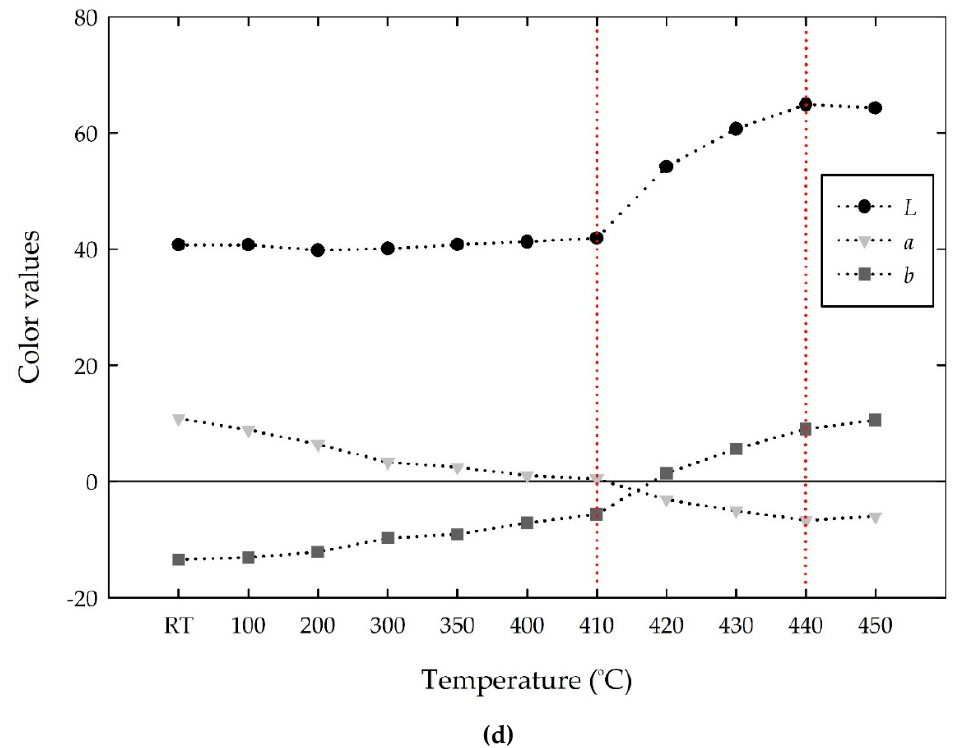
Figure 13. Changes in the Lab values of the white cement (WC) and MV mixed samples with increasing temperature: ( a ) WC; ( b ) WC + 1% MV; ( c ) WC + 3% MV; and ( d ) WC + 5% MV.